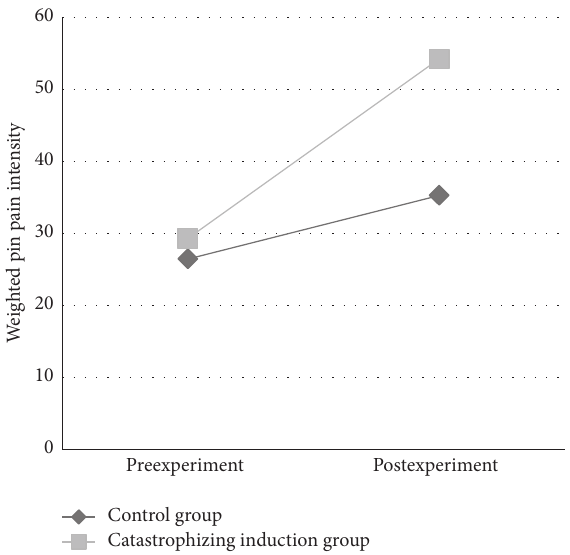
Figure 4: Weighted pin pain intensity over time by experimental condition. The interaction of time and condition on weighted pin pain intensity, controlling for baseline trait PCS and baseline current back pain intensity, was significant; weighted pin pain was signifi- cantly higher in the pain catastrophizing induction condition after the experiment compared to before the experiment (unstandardized 𝛽 = − 7.85, 𝑝 = 0.01